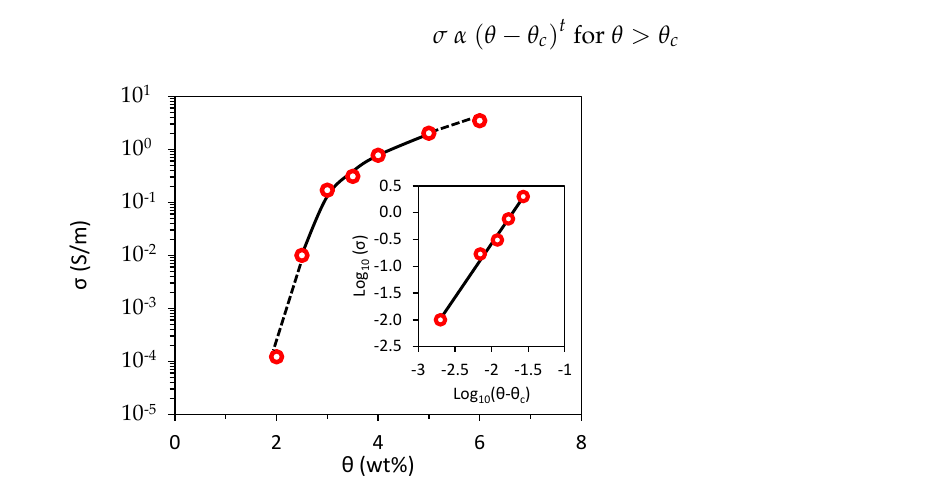
Figure 11. Electrical conductivity of the coatings as function of the GNP weight fraction.